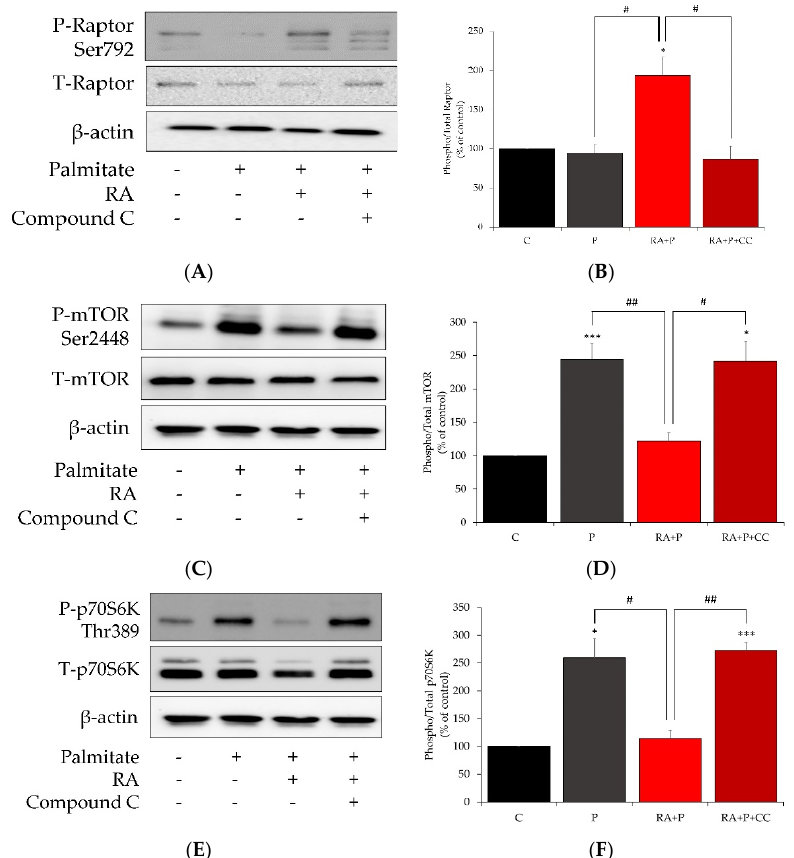
Figure 7. AMPK inhibition/compound C prevents the effects of rosmarinic acid on the phosphory- lation of Raptor ( A , B ), mTOR ( C , D ), and p70S6K ( E , F ). Fully differentiated myotubes were treated without (control, C) or with 25 μ M compound C (CC) for 30 min followed by treatment with 0.2 mM palmitate (P) for 16 h in the absence or the presence of 5 μ M rosmarinic acid (RA). After treatment, the cells were lysed, and SDS ‐ PAGE was performed, followed by immunoblotting with specific antibodies that recognize phosphorylated Ser 792 or total Raptor, phosphorylated Ser 2448 or total mTOR, and phosphorylated Thr 389 or total p70S6K. Representative immunoblots are shown ( A , C , E ). The intensity of the bands (arbitrary units) was measured using Image J software and expressed as percent of control ( B , D , F ). The data are shown as the mean ± SE of three separate experiments (* p < 0.05, *** p < 0.001 vs. control, # p < 0.05, ## p < 0.01 vs. RA + P).